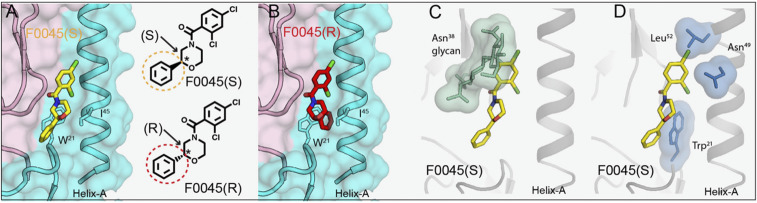
Structural basis of stereoselectivity and group 1 HA specificity. (A) S configuration of F0045 (yellow stick) in complex H1/PR8 HA. (B) Modeled R configuration of F0045 (red stick) in complex with H1/PR8 HA. HA1 is in light pink, and HA2 is in cyan. HA2 residues Trp21 and Ile45 are shown in stick representation. S and R configurations of the C ring of F0045 are highlighted in yellow and red circles, respectively. The asterisk indicates the stereocenter. (C and D) Superimposition of F0045(S) (yellow stick) bound to H1/PR8 HA on apo H3/HK68 (PDB ID 4FNK). HA is represented as a gray cartoon with selected residues in green and blue sticks with their surface representation. Only F0045(S) from the H1/PR8 HA complex is shown.